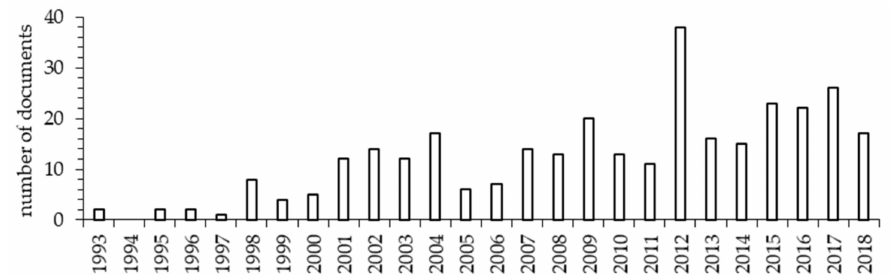
Figure 1. Number of documents published on organic livestock farming from 1993 to 2018 retrieved from Web of Science Core Collection using the following keyword combinations: Organic + Livestock + Farming and Organic + Husbandry +